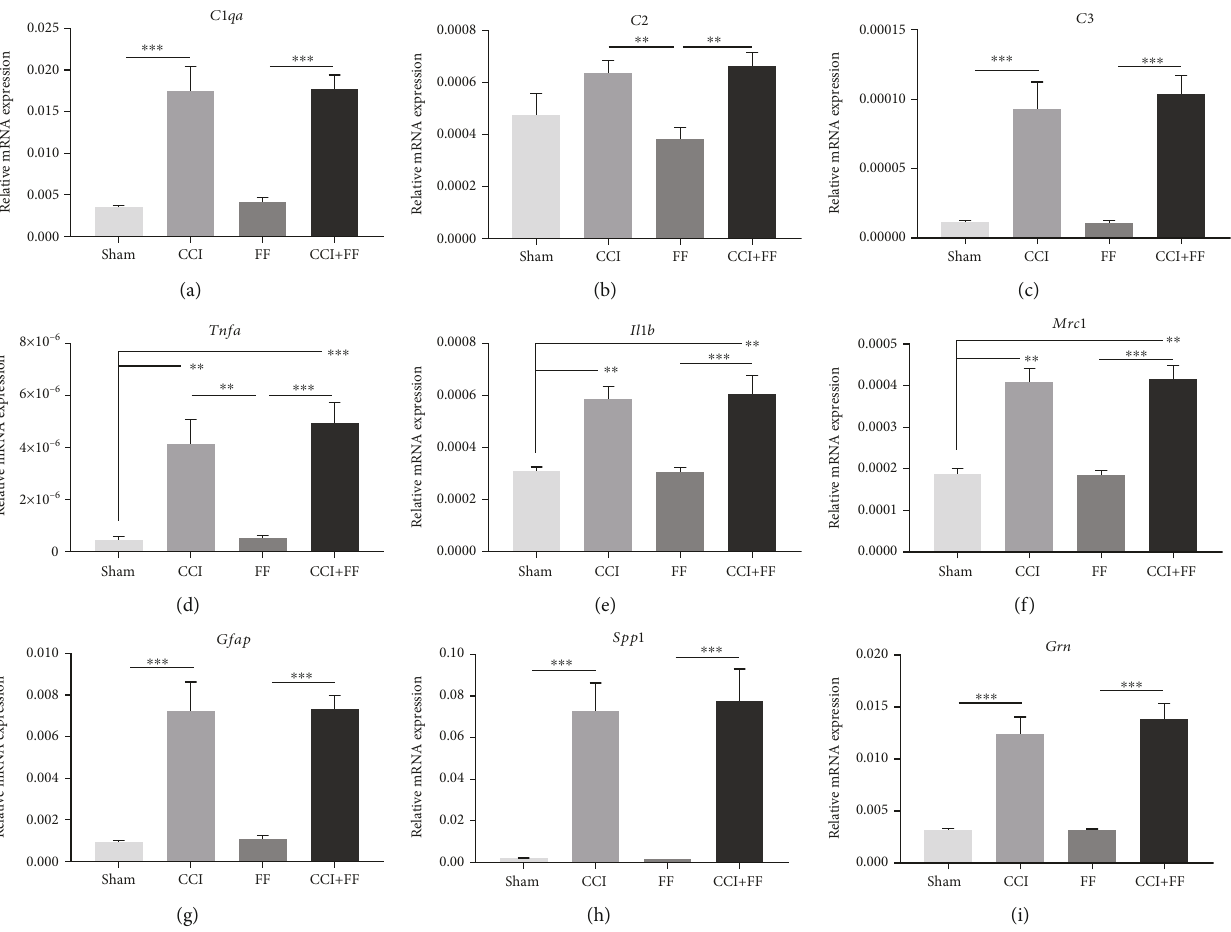
Figure 3: Femoral fracture does not in fl uence TBI-induced gene expression in the brain. (a – i) Gene expression analyses for brain in fl ammatory markers in perilesional brain tissue normalized to PPIA at 5dpi. mRNA expressions of all examined genes were increased in CCI and CCI+FF mice compared to sham and FF. Gene expression in CCI and CCI+FF was not signi fi cantly di ff erent. Values represent mean ± SEM ; p values were calculated by Holm-Sidak ’ s multiple comparison test or by Dunn ’ s multiple comparison test ( Mrc1 ,